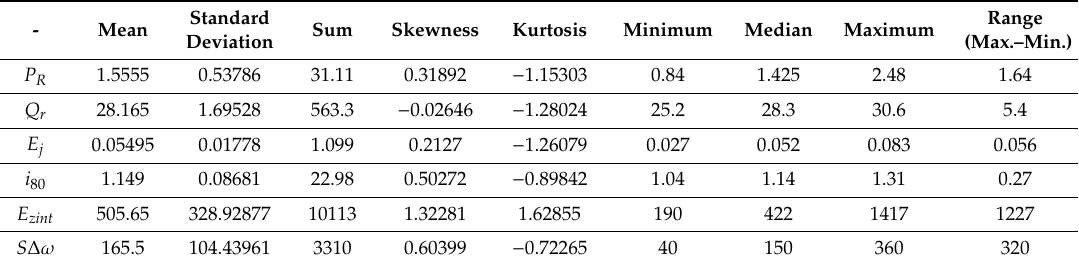
Table A3. Results of the descriptive statistical analysis of variables for the process of rice grinding.